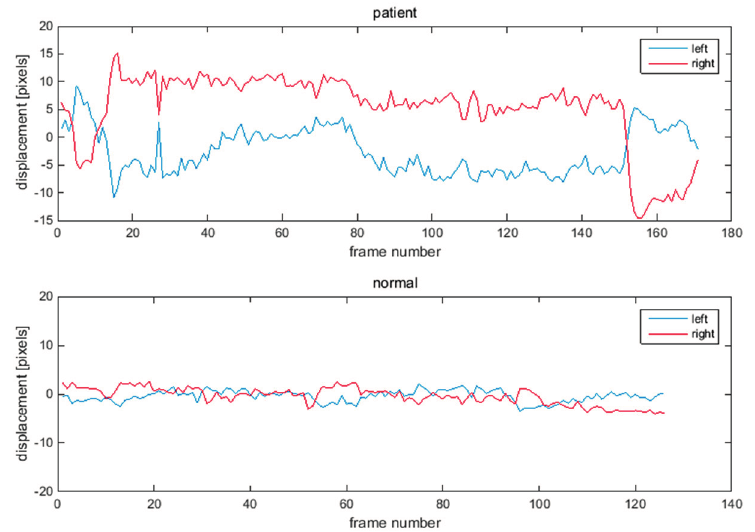
Figure 5. Displacements of eyebrow points during raising eye brow movement. Upper graph shows displacement of a patient. Lower graph shows displacement of a normal